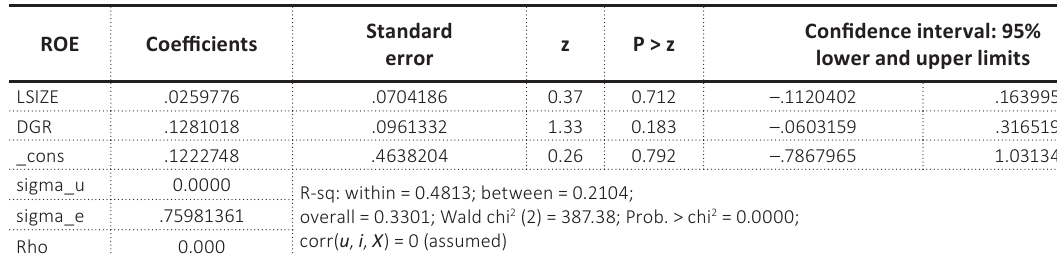
Table 2. Random effects model for pre-restructuring period